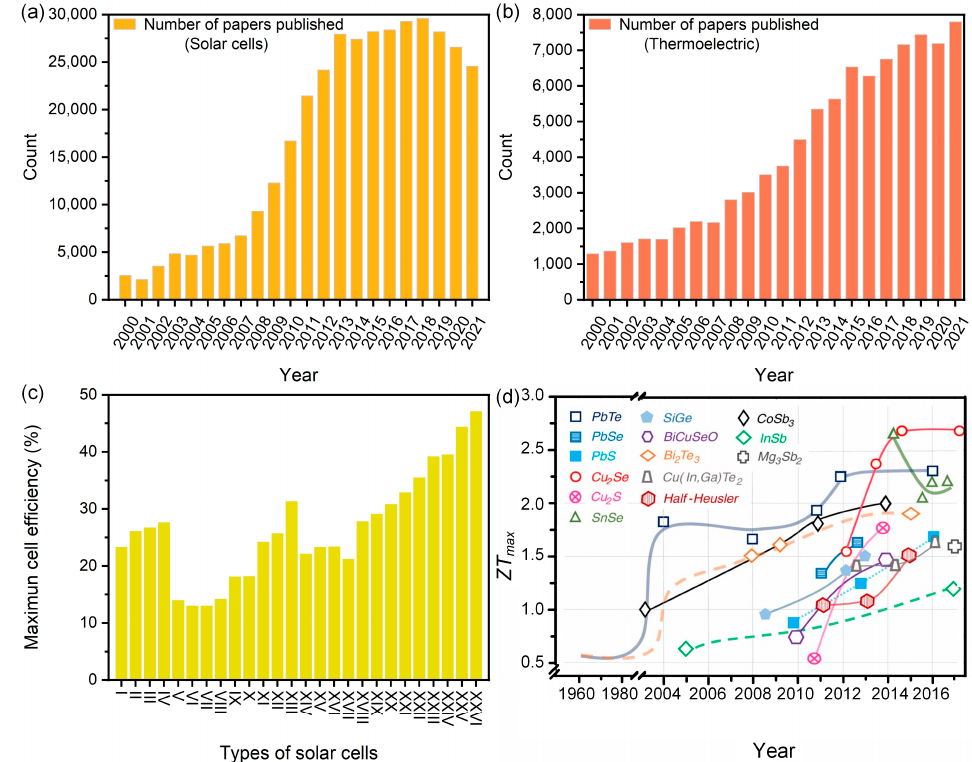
Figure 1. The number of papers published on ( a ) solar cells and ( b ) thermoelectric according to year. Source: Web of Science. Clarivate Analytic Data, https://www.webofscience.com/wos/, accessed on 15 July 2022. ( c ) The highest confirmed conversion efficiencies of research cells for a range of photovoltaic technologies. Label of solar cells as shown in Table 1. Source: National Renewable Energy Laboratory (NREL), accessed on 30 June 2022. ( d ) Timeline of the maximum ZT values for several representative families of TE materials. Reprinted with permission from [31] Copyright 2017, American Association for the Advancement of Science, AAAS.